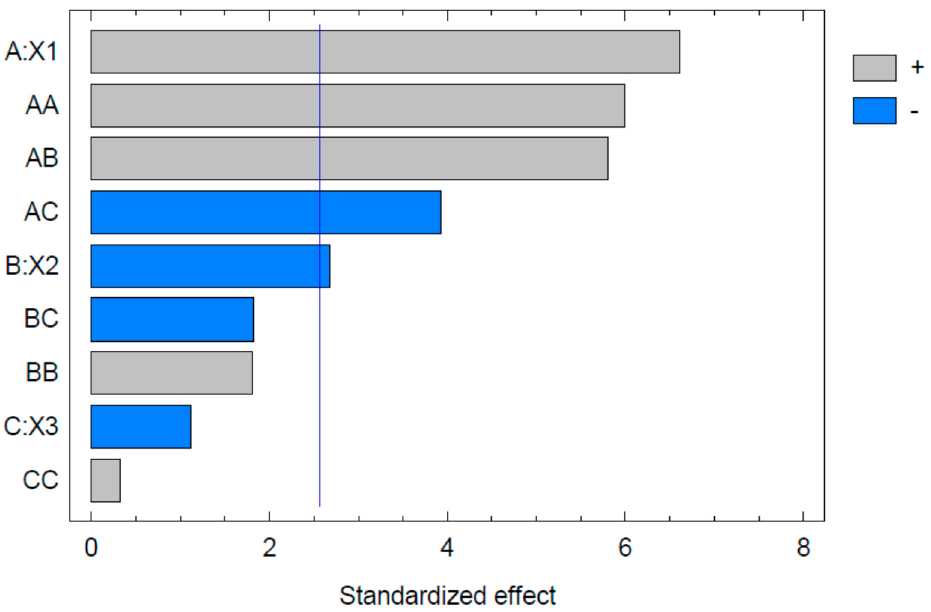
Figure 2. Pareto chart for globule size where X1 represent concentrations of Capryol 90, X2 represent Tween 20, and X3 represent PEG 200.